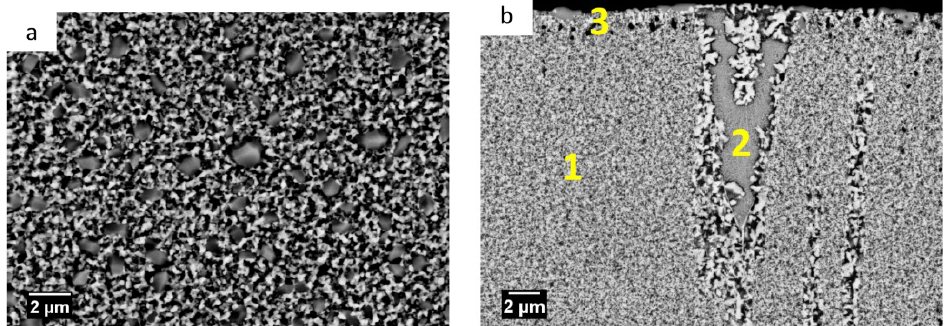
Figure 2. X-ray diffraction patterns of Fe-24W alloys annealed at different temperatures ( a ), and X-ray diffraction patterns of Fe-24W sample annealed at 800 °C acquired with Bragg–Brentano and grazing incidence geometry ( b ).